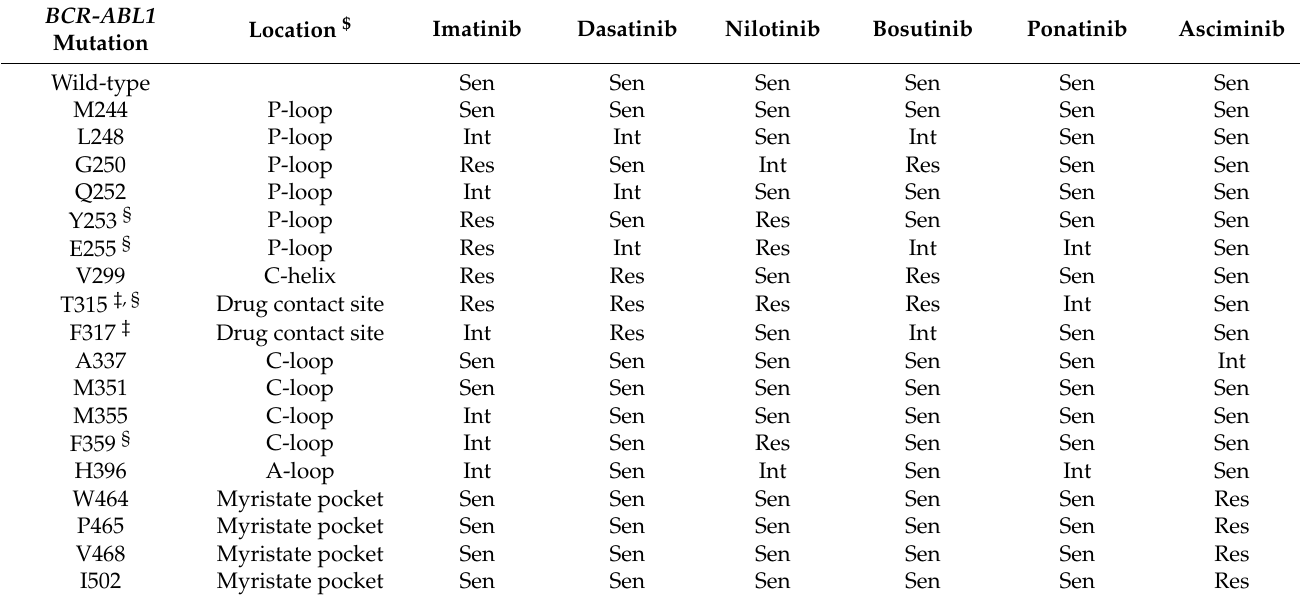
Table 1. Most frequent BCR-ABL1 mutation and the sensitivity degree to the approved